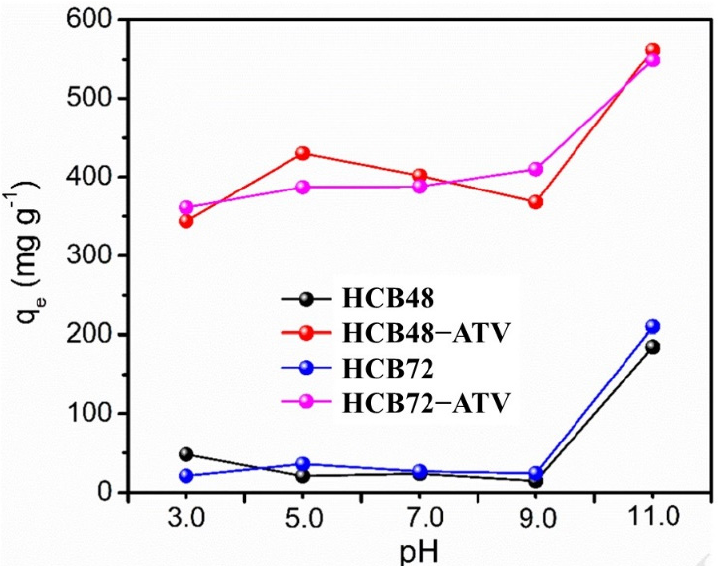
Figure 3. Adsorption capacity of the activated and non-activated HCB as function of pH [29] (with permission of Elsevier, Copyright year: 2022). permission of Elsevier, Copyright year: